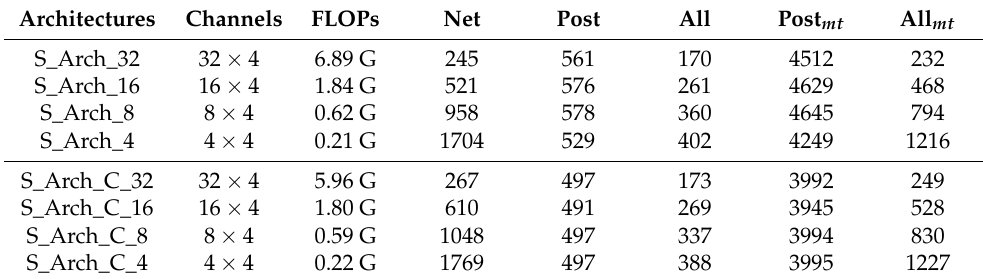
Table 8. Computation efficiency in FPS